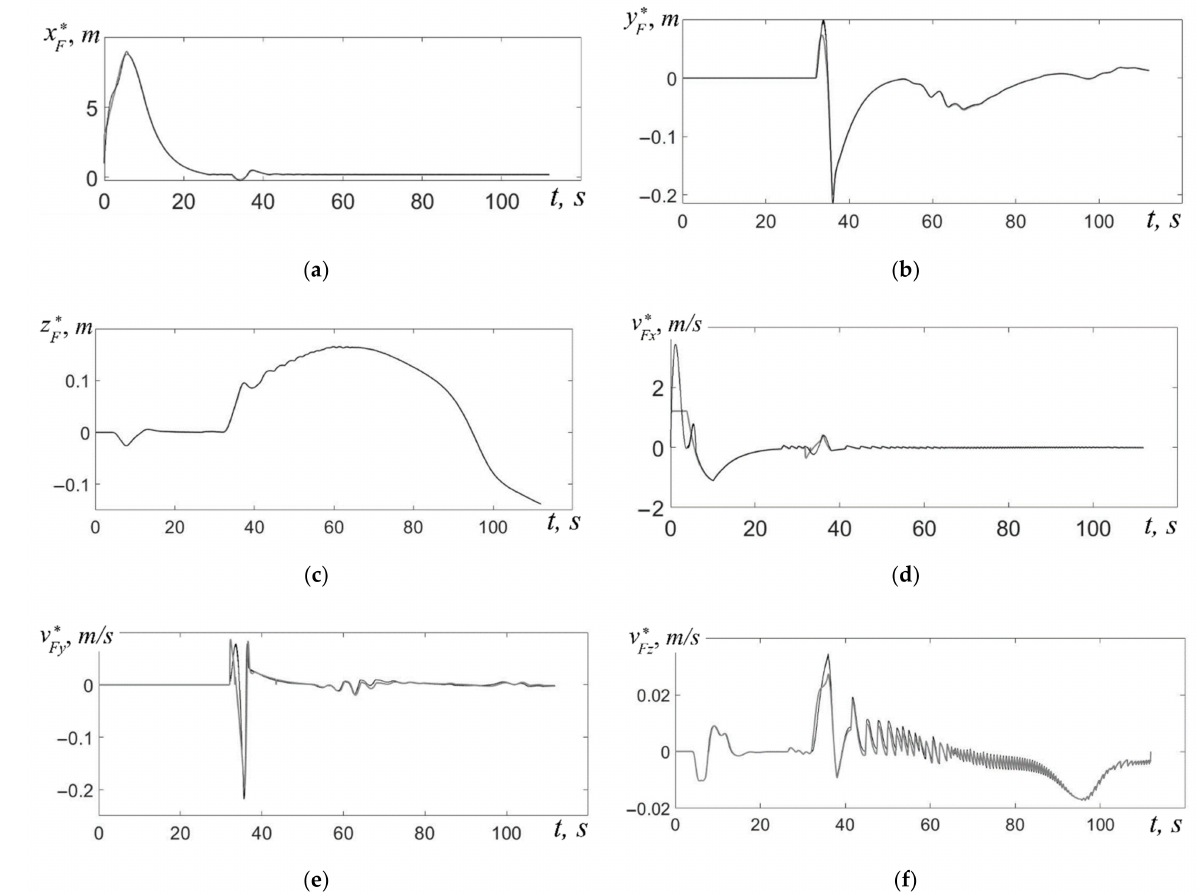
; ( b ) is the y ∗ ; ( c ) is the F F